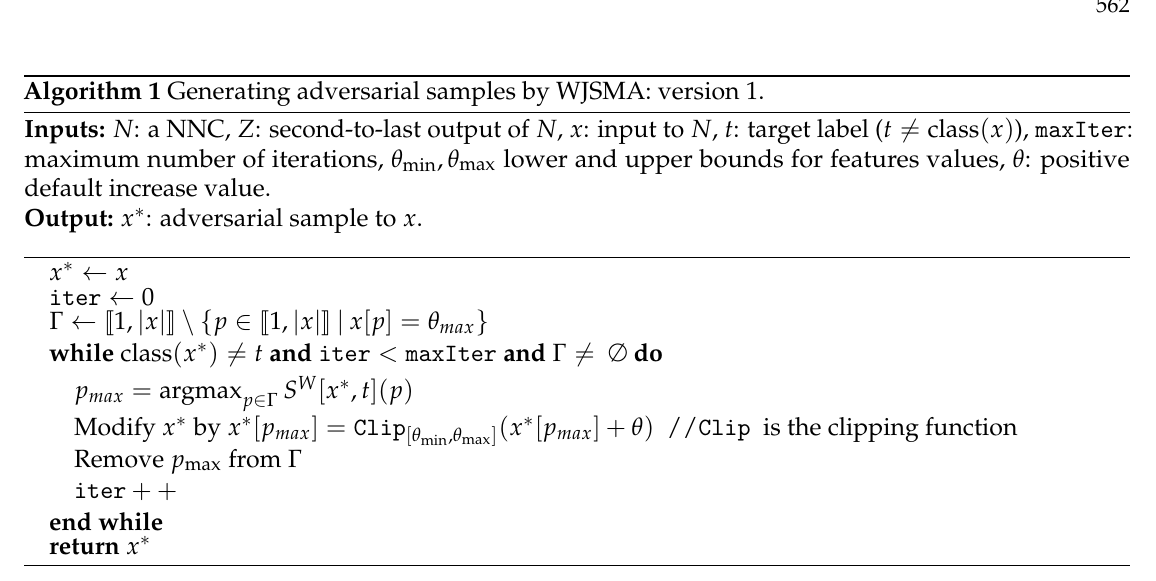
Algorithm 1 Generating adversarial samples by WJSMA: version 1.